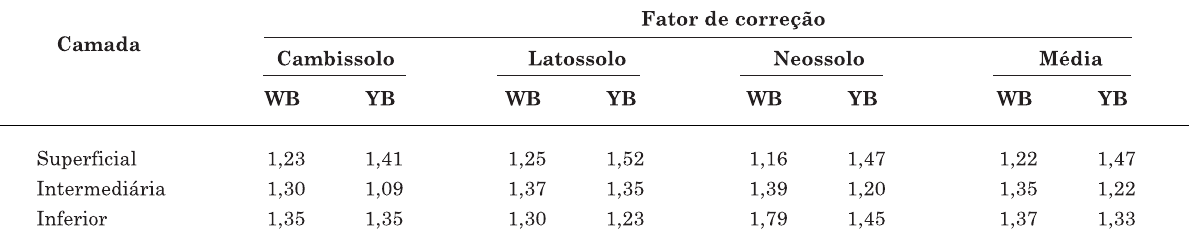
Quadro 2. Fator de correção médio por camadas e classes de solo dos teores de C determinados pelos métodos de combustão úmida, Walkley-Black (WB) e Yeomans & Bremner (YB), em relação aos do método